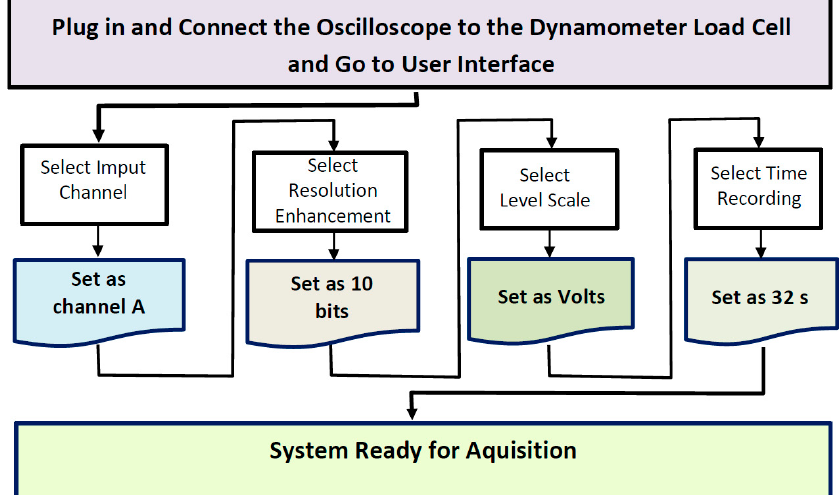
Figure 2. Oscilloscope graphic user interface with complete parameters selection guide used for the data selected for analysis.